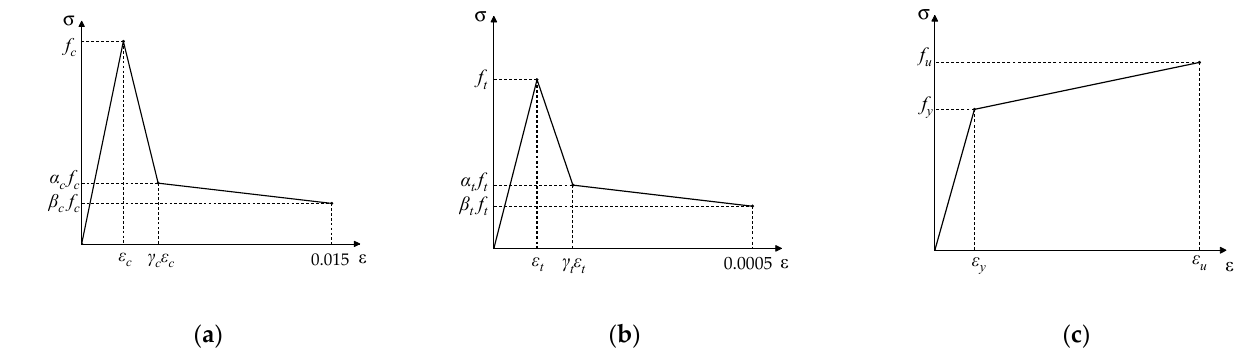
Figure 11. Constitutive laws of materials: ( a ) compressive behavior model of SFRCC; ( b ) tensile behavior model of SFRCC; and ( c ) bifold line model of steel.